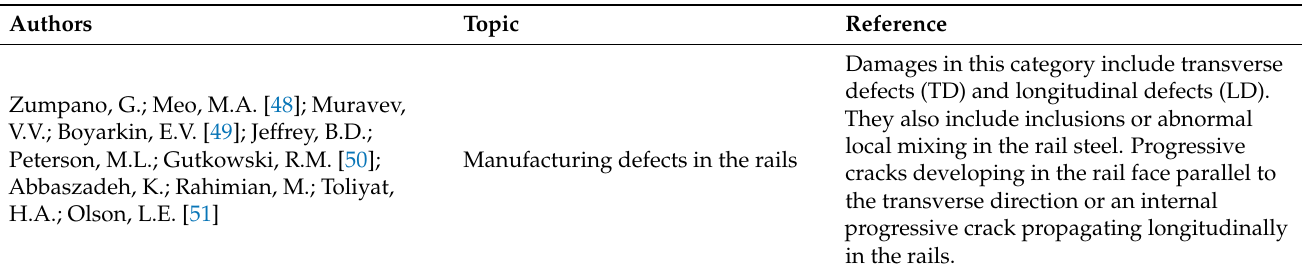
Table 1. Overview of rail defects and their detection